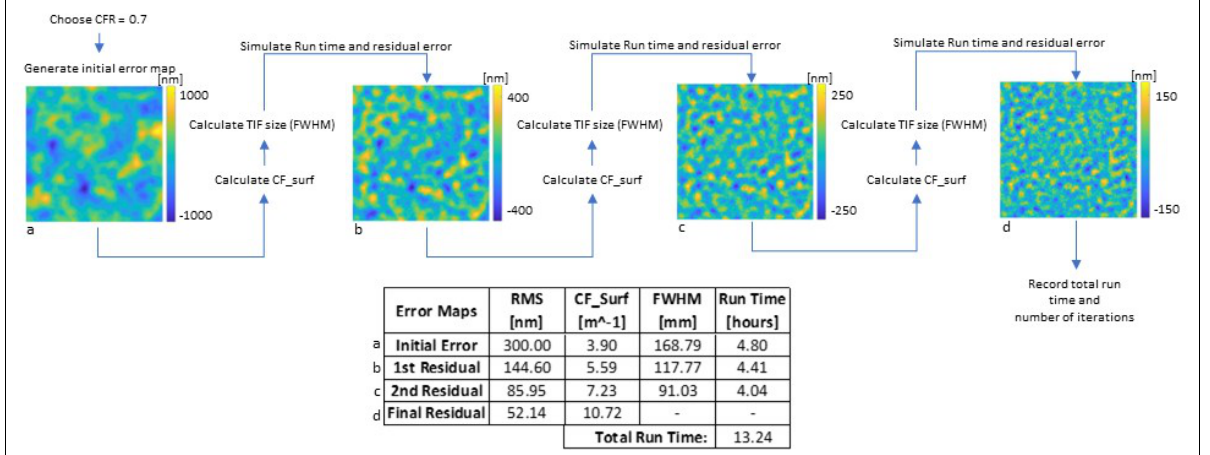
Figure 6. Simulation example for one iteration of test case with CFR = 0.7 showing ( a ) initial error map, ( b ) first residual error map, ( c ) second residual error map, and ( d ) final residual error map, with a table keeping track of the RMS value and CF of each map, the FWHM of the Gaussian TIF used on each map, and the calculated run time required for each